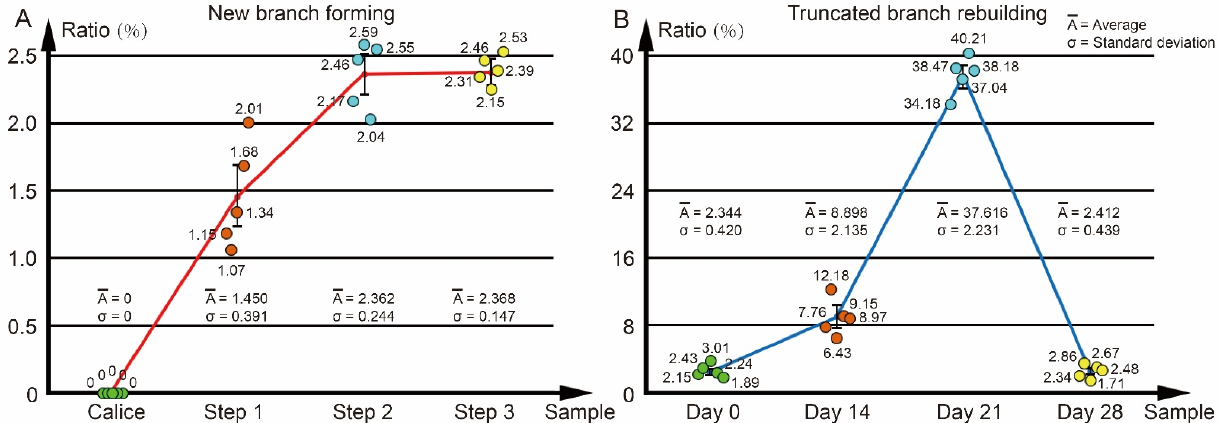
Figure 5. Volume ratio of calcium carbonate deposition in the lumen of axial corallite under different growth processes. ( A ) The volume ratio changed during the new branch formation. Green: sample at status of Calice; Red: sample at status of Step 1; Blue: sample at status of Step 2; Yellow: sample at status of Step 3. ( B ) The volume ratio changed during the truncated tip repair. Green: sample at Day 0; Red: sample at Day 14; Blue: sample at Day 21; Yellow: sample at Day 28. In the A. muricata branch, the distance among adjacent calices was similar, and the calices circled the axial corallite along the growth direction. The distances from each calice bottom to the axial corallite were also similar, and complex gastrovascular canals linked the polyps in them (Figure 3). When an A. muricata colony branches, the axial canal reveals